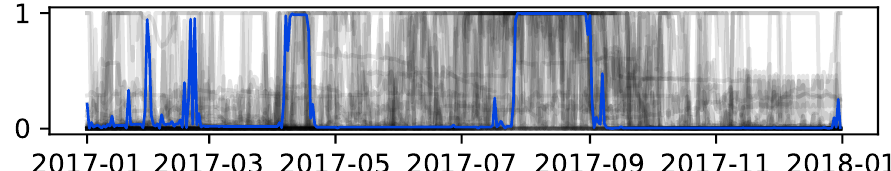
Figure 14. K-means 13th cluster and barycenter for the scaled daily consumption at InfraQuinta,